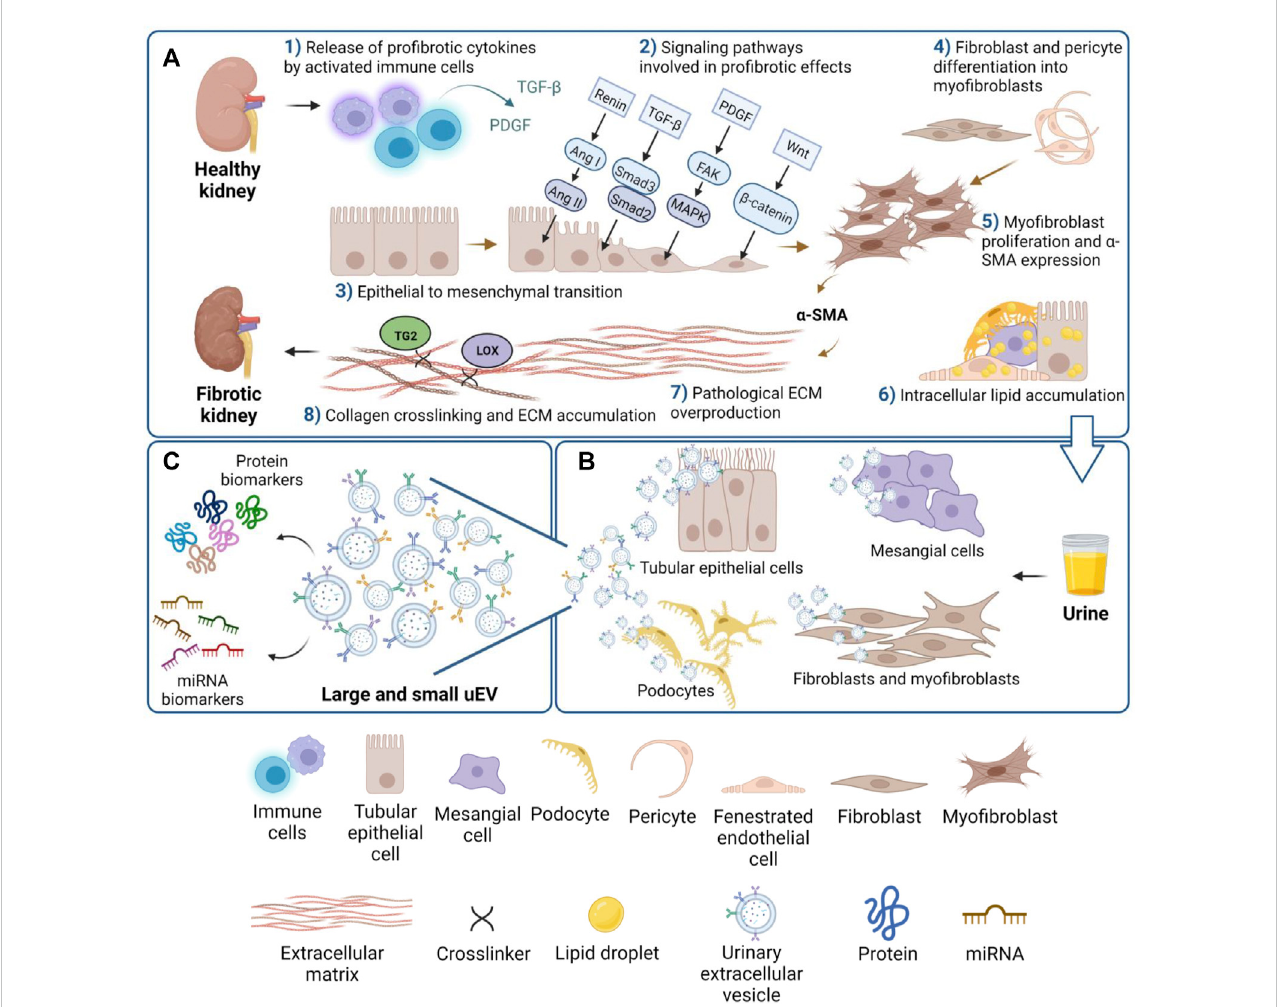
Overview of the main cell and tissue changes leading to kidney fi brosis. (A) Schematic view of eight of the main events involved in fi brosis: activation of cellsandreleaseofcytokines(1);activationofpro fi broticsignalingpathways(2);EMT(3);differentiationofmesenchymalcelltypestoactivatedmyo fi broblasts (4); α -SMA expression (5); accumulation of lipids drops in renal cells (6); ECM synthesis and overproduction (7); collagen crosslinking (8). (B) uEVs secreted from speci fi c renal cell types can be collected in urine, and (C) the uEVs cargo of protein and miRNA likely mirrors the fi brotic